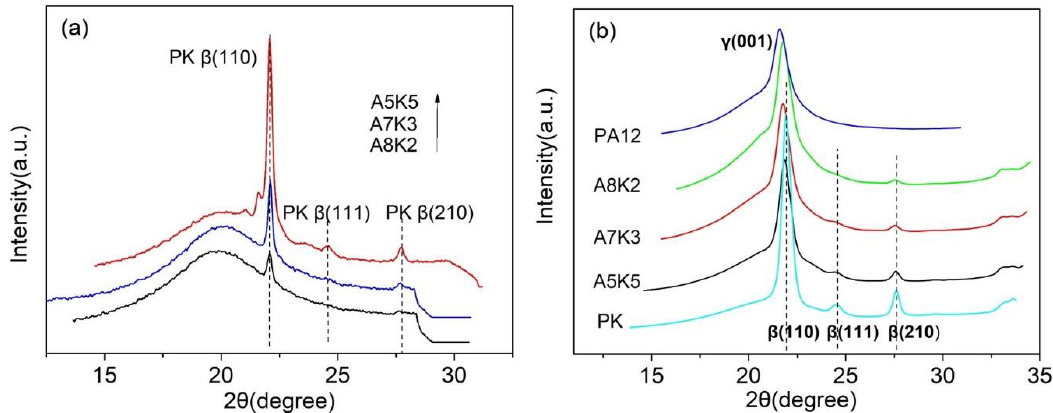
Figure 8. One-dimensional (1D)-wide angle X-ray (WAXD) intensity curves of A5K5, A7A3 and A8K2 blends: ( a ) at 170 °C; ( b ) at 25 °C.